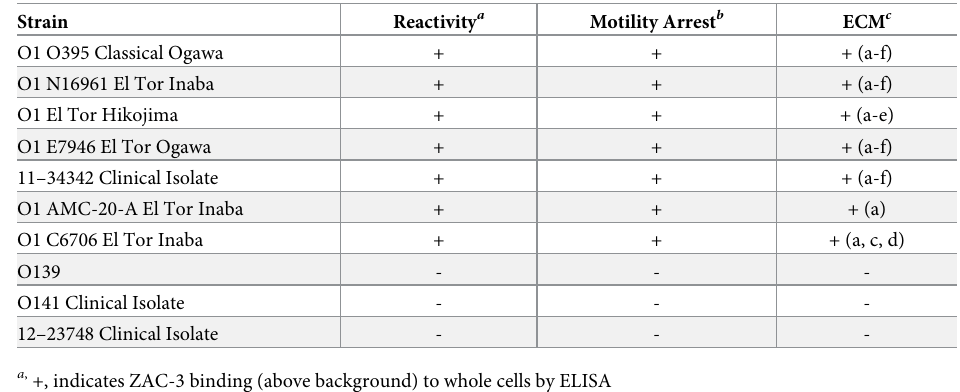
Table 1. Response of Vibrio cholerae strains to ZAC-3